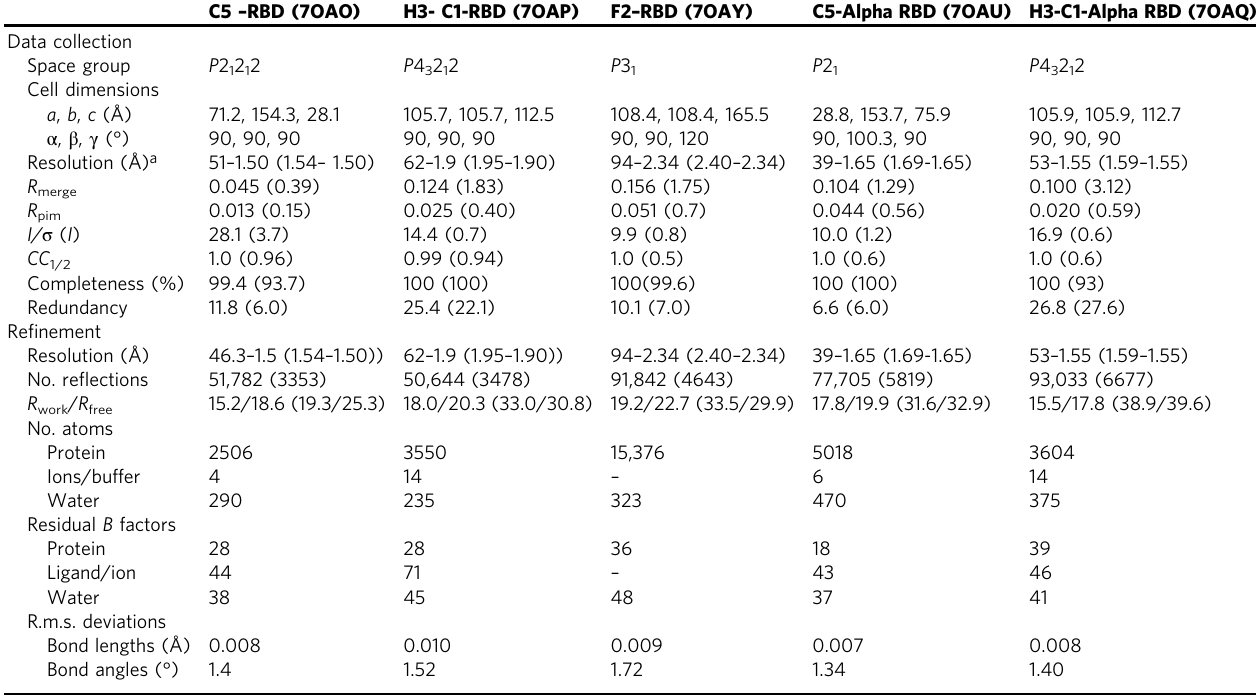
Table 2 X-ray crystallography data collection and re fi nement statistics. C5 – RBD